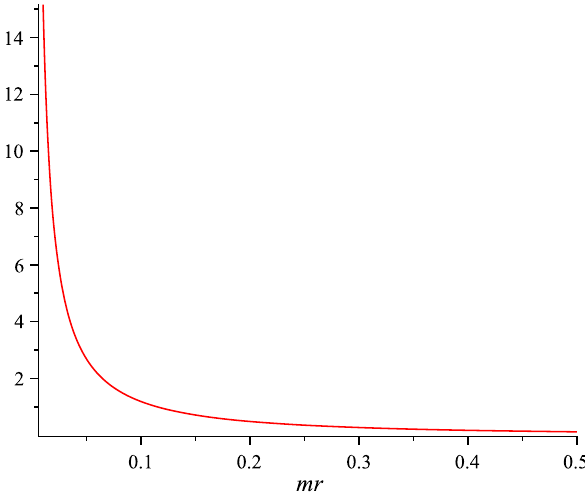
Fig. 7 Plot for the difference between the modulus of the electric and the magnetic fields divided by m σ , for the point-like charge, and m 2 (cid:15) , for the Dirac point, of Eq’s. (48) and (45),